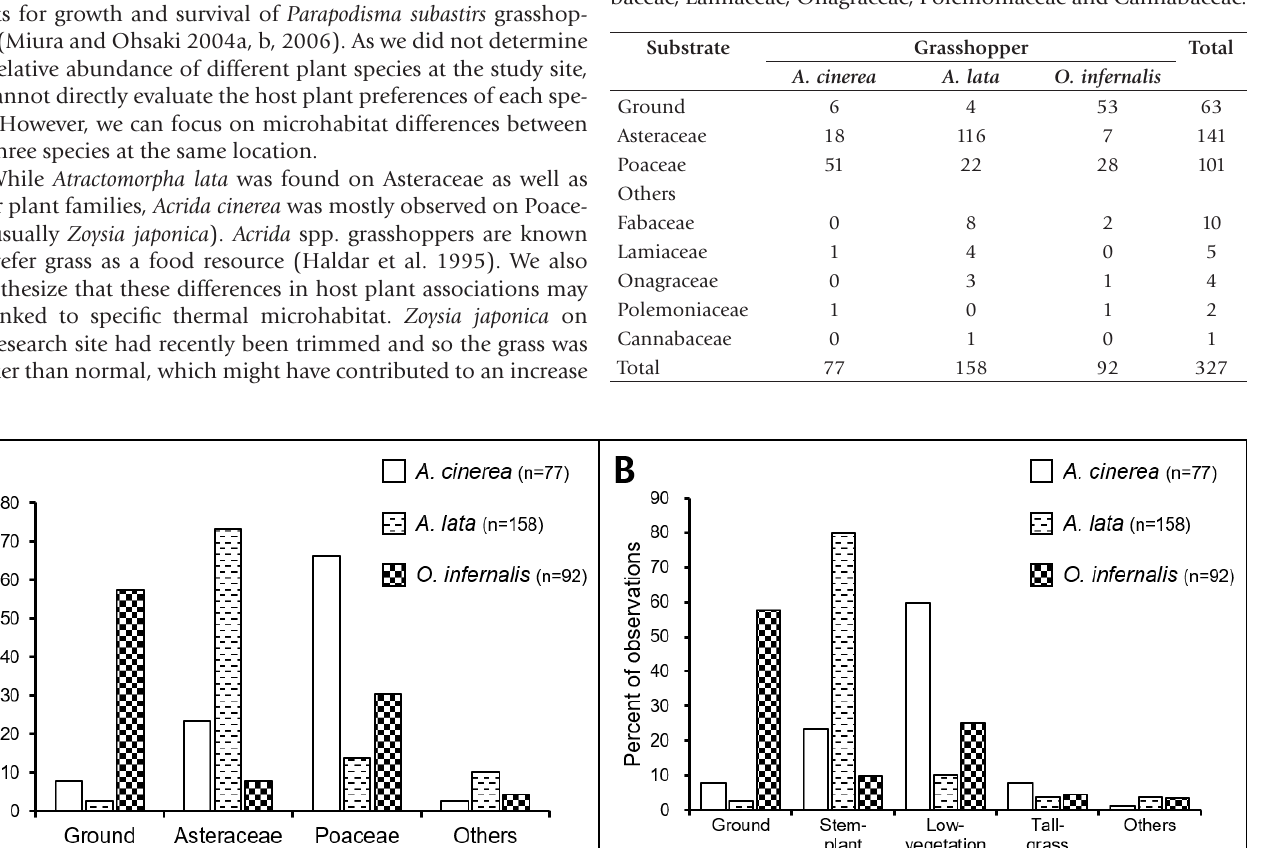
Table 1. Number of individuals of the three grasshopper